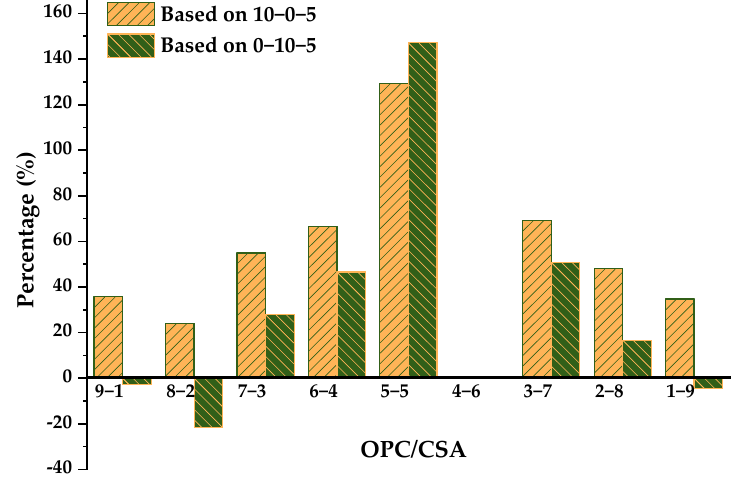
Figure 12. Drying shrinkage of ternary systems with 5% CS and comparison.